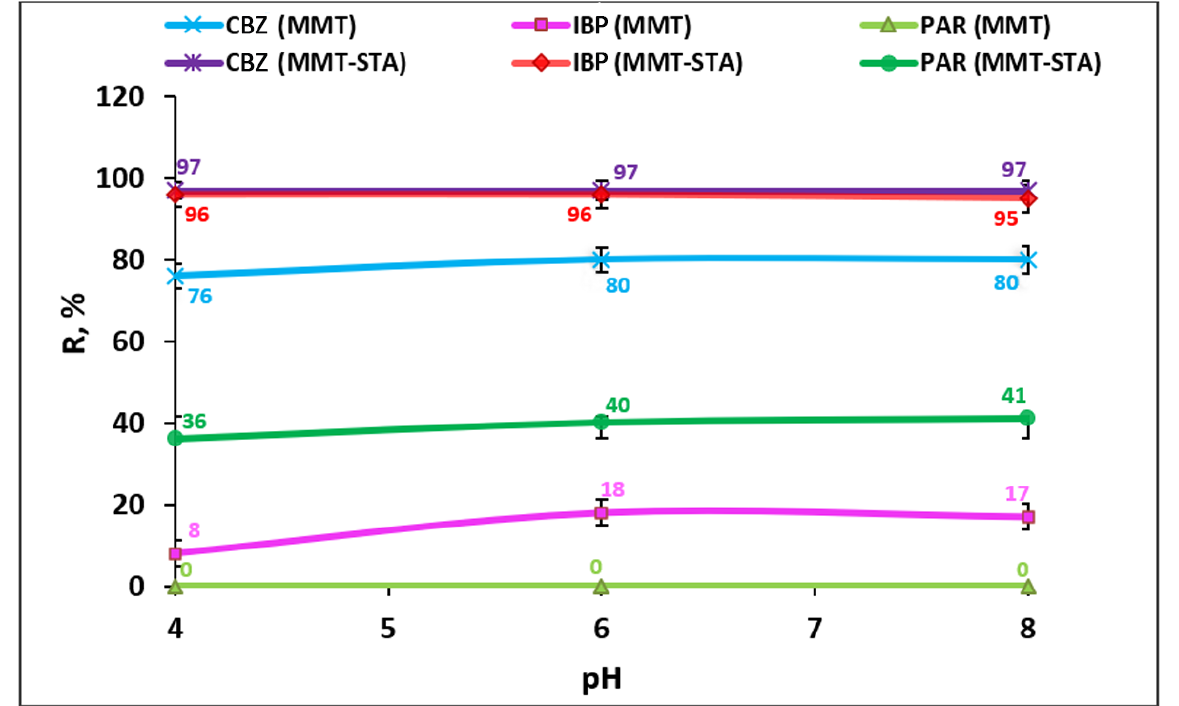
Figure 6. Effect of pH on the removal efficiency of PP by pristine MMT and modified MMT–STA. The pKa of CBZ and PAR are 13.9 and 9.38, respectively; thus, most of their molecules were uncharged in the studied pH range (pH 4–8). Thus, electrostatic interactions ap- parently played a little role in the adsorption of these drugs by hydrophobic MMT–STA. According to octanol-water partition coefficients, all the drugs tested were rather hy- drophobic, with hydrophobicity decreasing in the row CBZ → IBP → PAR. Thus, it is more probable that hydrophobic interactions contributed to the efficient adsorption of these drugs by hydrophobic MMT–STA clay. Electrostatic interactions could only take place in case of IPB adsorption on positively charged MMT–STA, which has pKa of 4.91, indicating that most of its molecules would be negatively charged at pH about 4. Thus, the